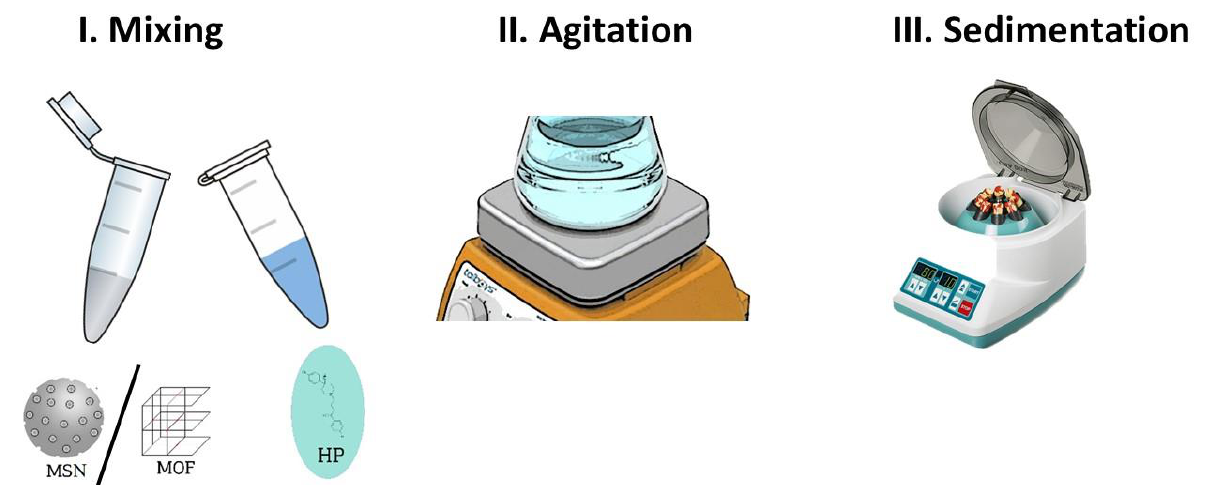
Figure 1. Preparation protocol for haloperidol loading to MSN/MOF nanoparticles.